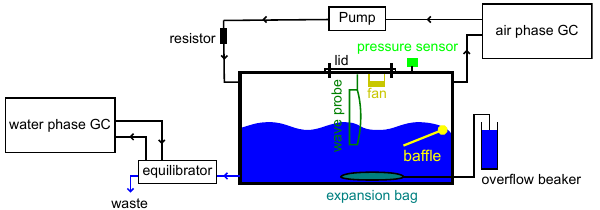
Figure 1. Schematic of the gas exchange experiment. The seawater sample (93L) is contained in a gas-tight tank (0 . 73m × 0 . 48m × 0 . 48m internally). Water-side turbulence is created with a baffle driven by a stepper motor. An automatic equilibration circuit (de- tails see Fig. 3) regularly takes water samples and equilibrates the water with an “equilibrator gas” of known SF 6 , CH 4 and N 2 O com- position, before measuring resulting gas partial pressures in a gas chromatograph (GC). Air phase gas partial pressures are constantly measured with a second GC. Wave spectra at a single point are ac- quired with a capacitance wave probe. Pressure and temperature in the tank and the equilibrator as well as total ambient pressure are continuously monitored.